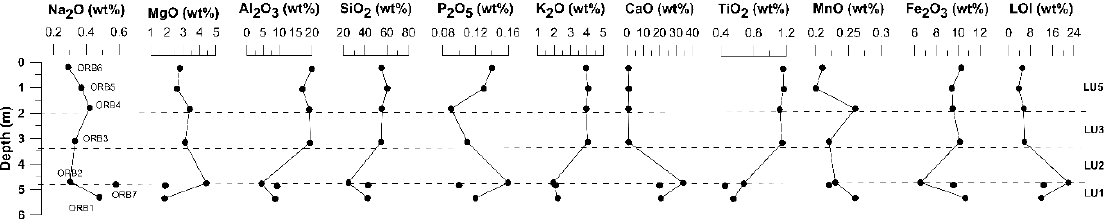
Figure 6. Vertical distribution of major chemical components and loss on ignition (LOI). The vertical lines connect the samples of Section A. Dashed horizontal lines indicate the different lithological units (acronym on the right). The main features of each single unit are summarized in Figure 4 and described in Section 3.1. LU4 (between LU5 and LU3) was not sampled.